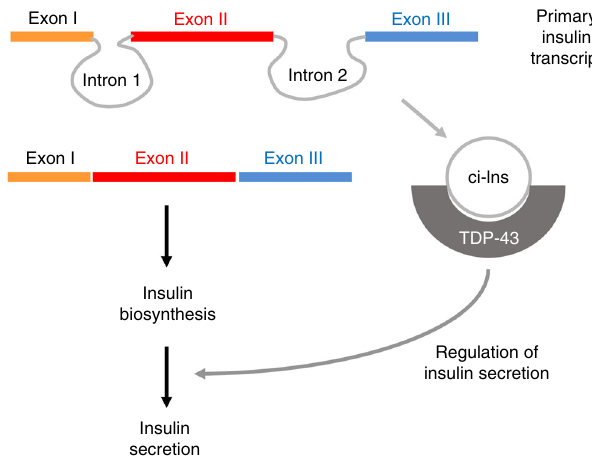
Fig. 10 ci-Ins is required for optimal insulin secretion. In β -cells, the primary insulin transcript is processed to generate the mature mRNA that is translated for insulin biosynthesis. In parallel, the second intron excised from the primary insulin transcript forms a stable circular RNA (ci-Ins2/ci- INS) that associates with the RBP TDP-43 and controls the expression of genes necessary for optimal insulin release in response to secretory